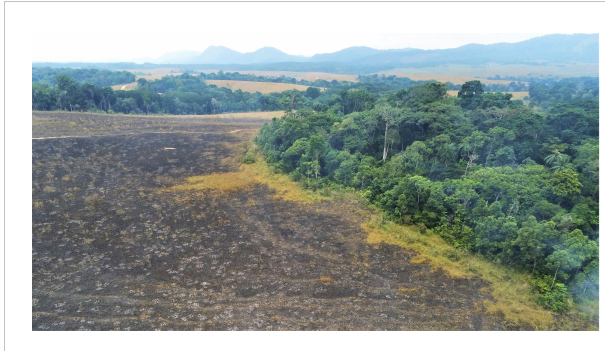
FIGURE 3 A forest edge in Lope ́ National Park, Gabon, shortly after the adjacent savanna burnt. The fi re was extinguished by the buffer of slow curing, low fl ammability grasses before reaching the forest edge. (Photo: A. W.